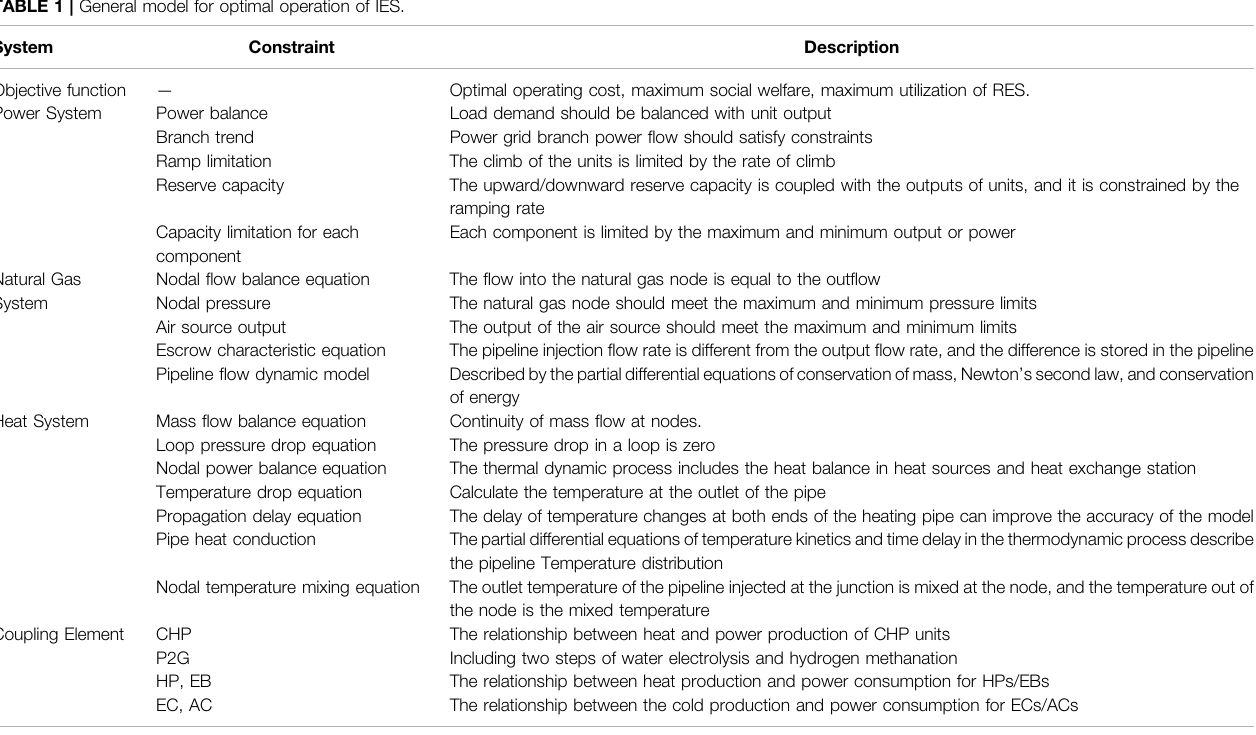
TABLE 1 | General model for optimal operation of